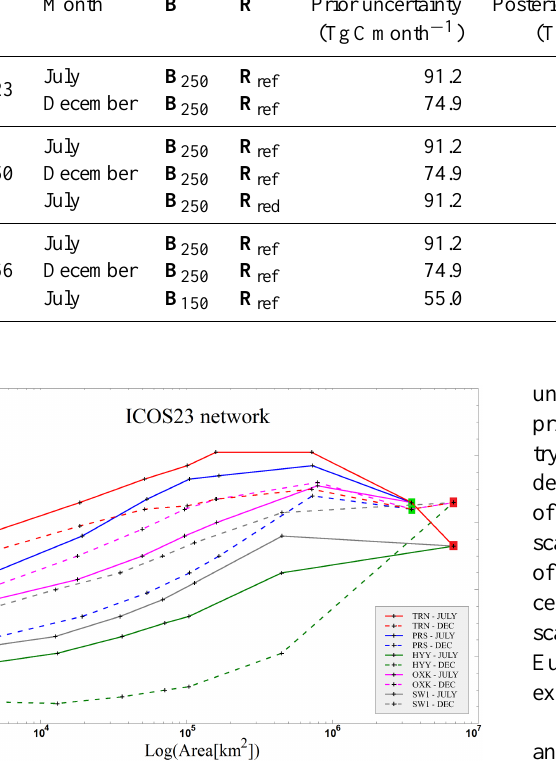
Atmos. Chem. Phys., 15, 12765–12787,